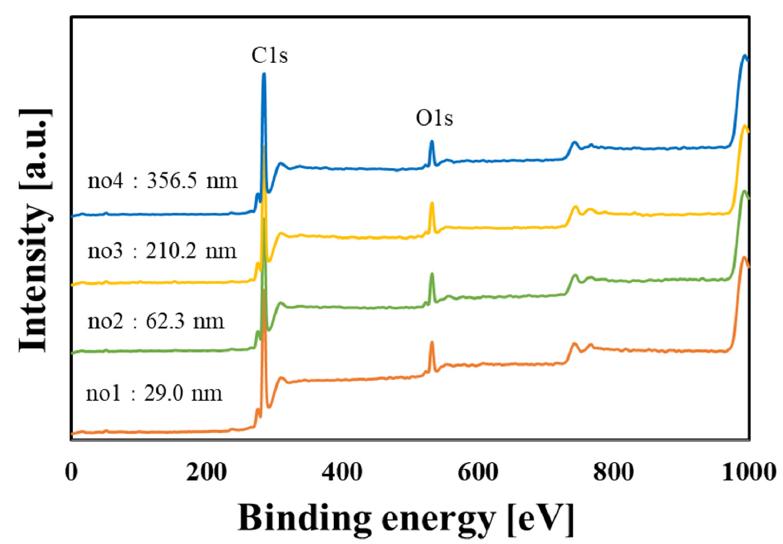
Figure 6. XPS wide scan spectra of the PLC films with different thicknesses.